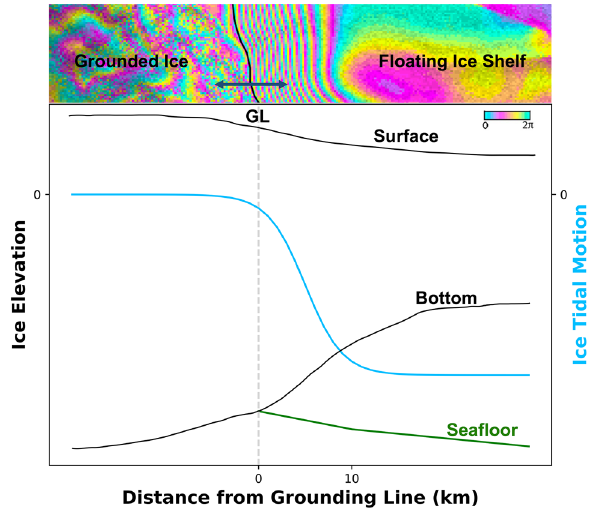
Figure 1. Schematic of the ice surface, ice bottom elevation, sea floor depth, and vertical tidal motion of the ice in the grounding zone versus a differential SAR interferogram on top. The grounding line (GL), represented by the vertical gray dashed line, is at the inner-most fringe of the grounded ice side. The differential motion in the tidal flexing zone produces a dense fringe pattern used by the neural network to identify grounding lines. The direction of horizontal migration of the GL is shown by the double-sided dark blue